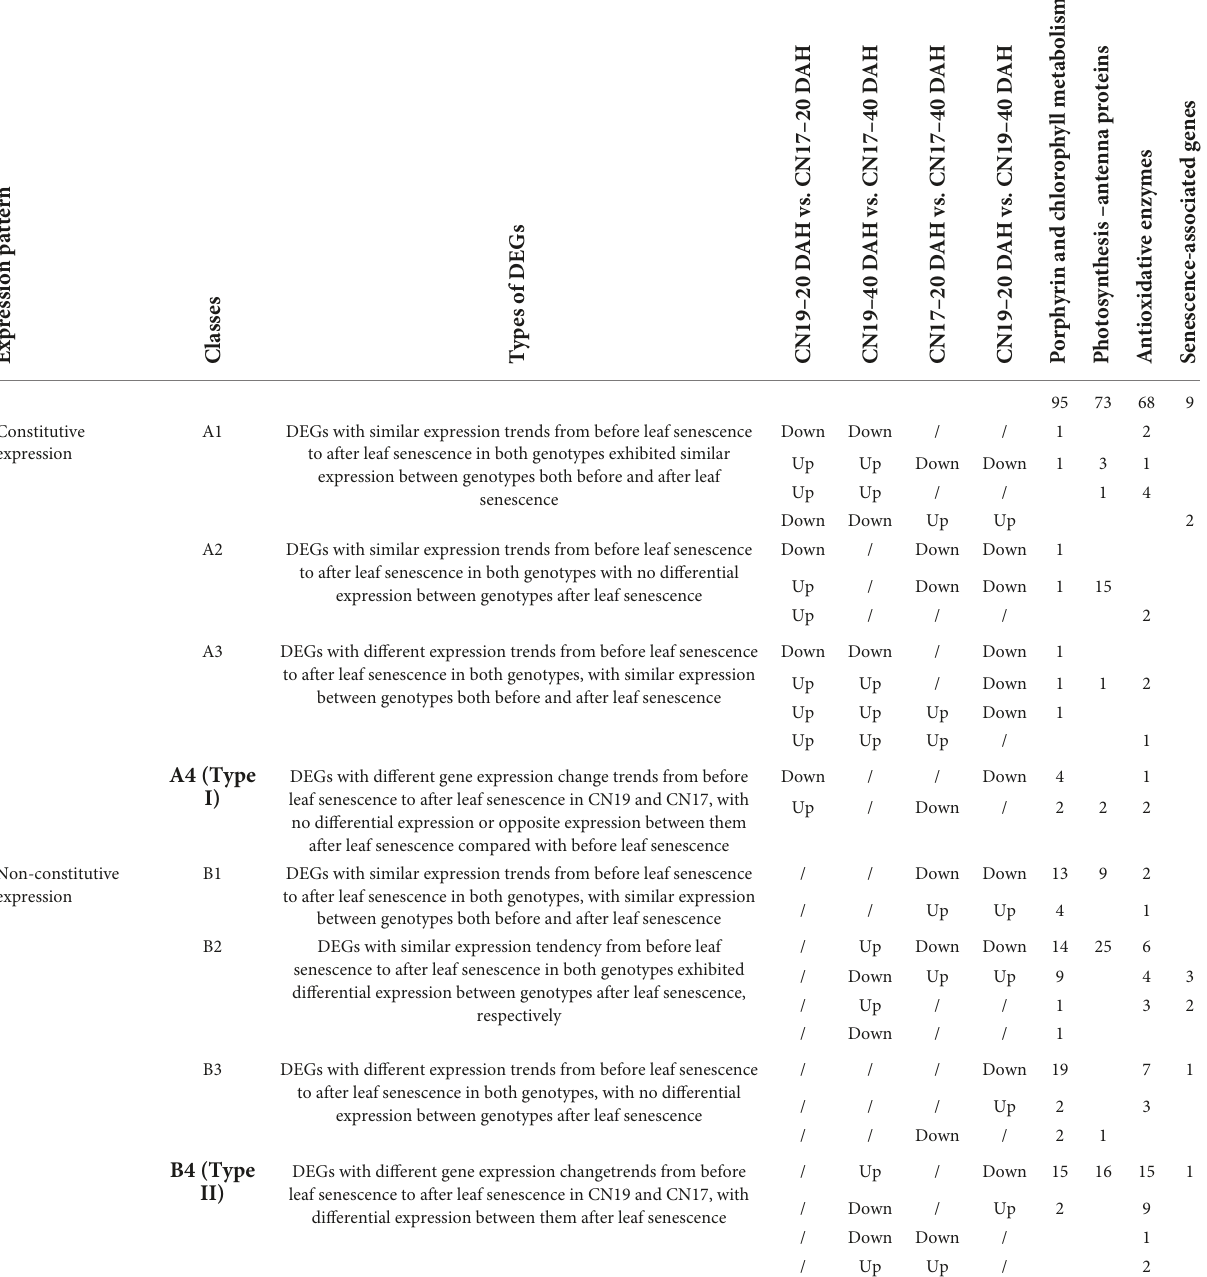
DEGs with different gene expression change trends from before leaf senescence to after leaf senescence in CN19 and CN17, with no differential expression or opposite expression between them after leaf senescence compared with before leaf senescence DEGs with similar expression trends from before leaf senescence to after leaf senescence in both genotypes, with similar expression between genotypes both before and after leaf senescence DEGs with similar expression tendency from before leaf senescence to after leaf senescence in both genotypes exhibited differential expression between genotypes after leaf senescence,